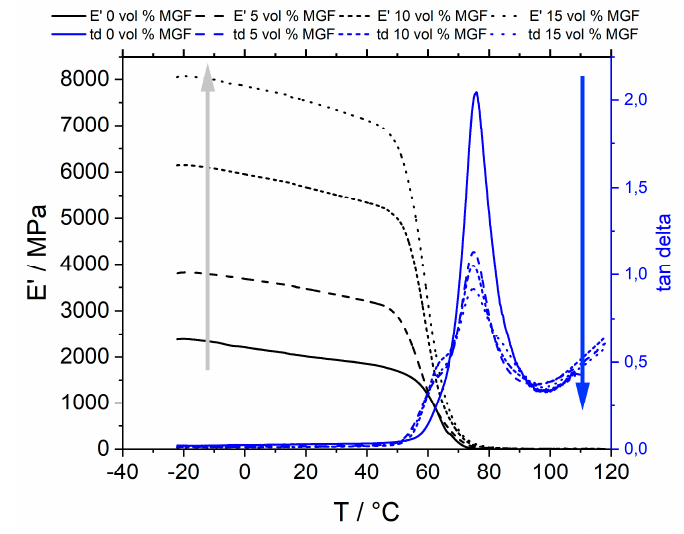
Figure 17. Temperature-dependent storage modulus E’ of PVB filled with MGF of type GF100.